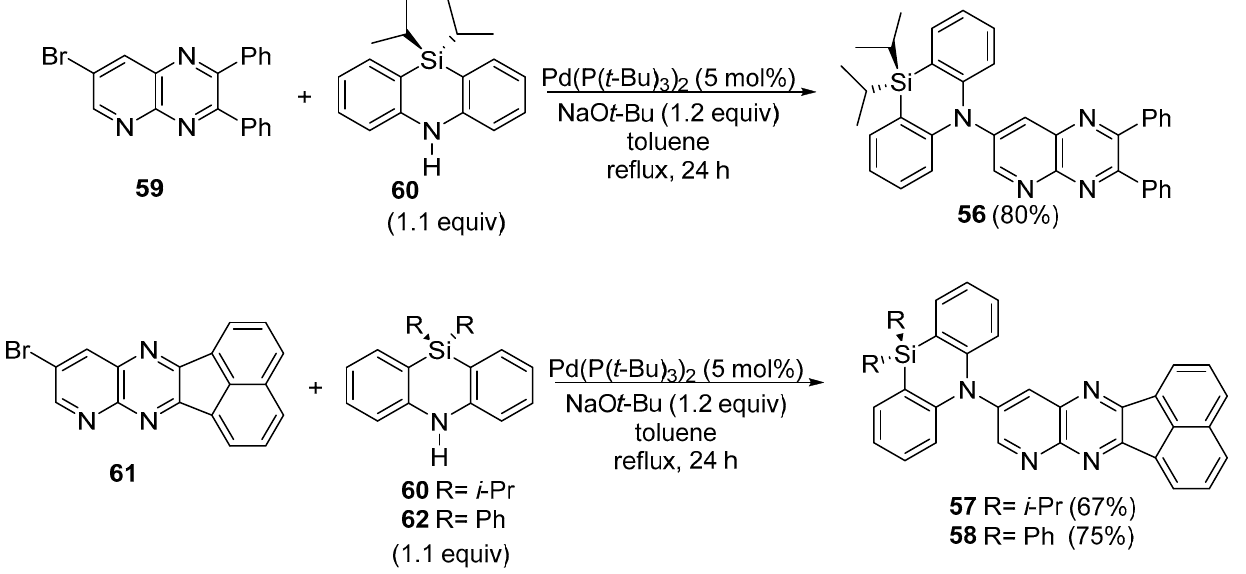
Table 10. The photophysical properties of the compounds 56 – 58